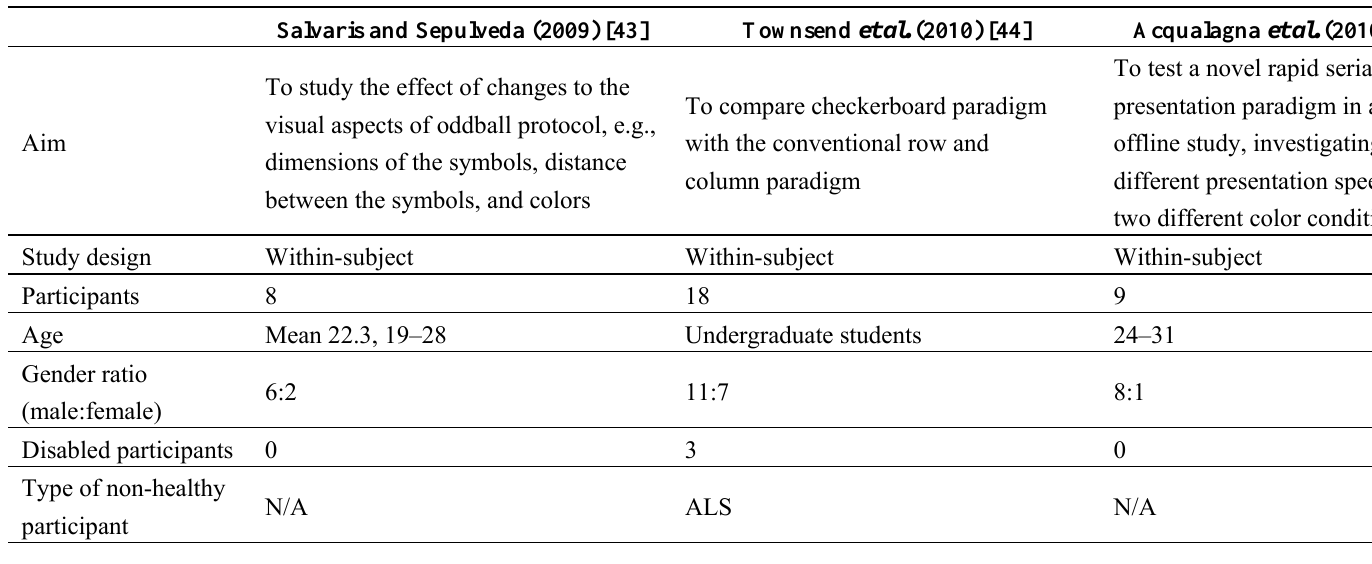
Table 1. Studies selected for